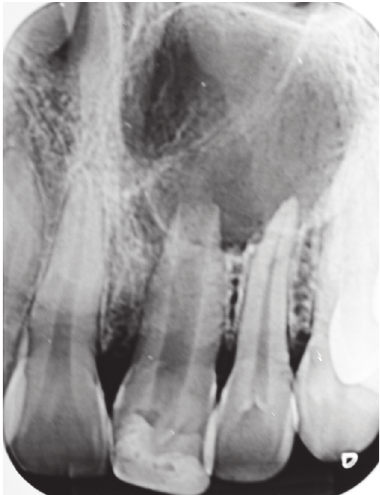
Figure 2: Intracanal medication of calcium hydroxide.